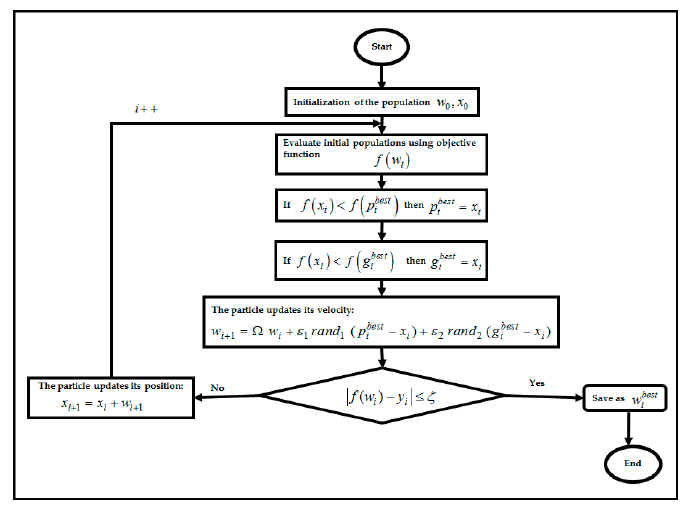
Figure 5. Flowchart of RBFNN-2SATRAPSO. PSO = particle swarm optimization.